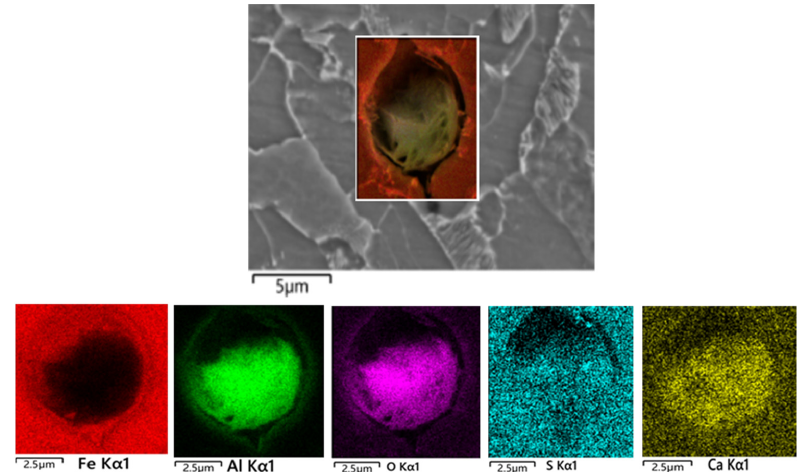
Metals 2022 , 12 , x FOR PEER REVIEW Figure 8. SEM and EDS morphology of typical Al 2 O 3 -CaS inclusions in 1# sample. Figure 8. SEM and EDS morphology of typical Al